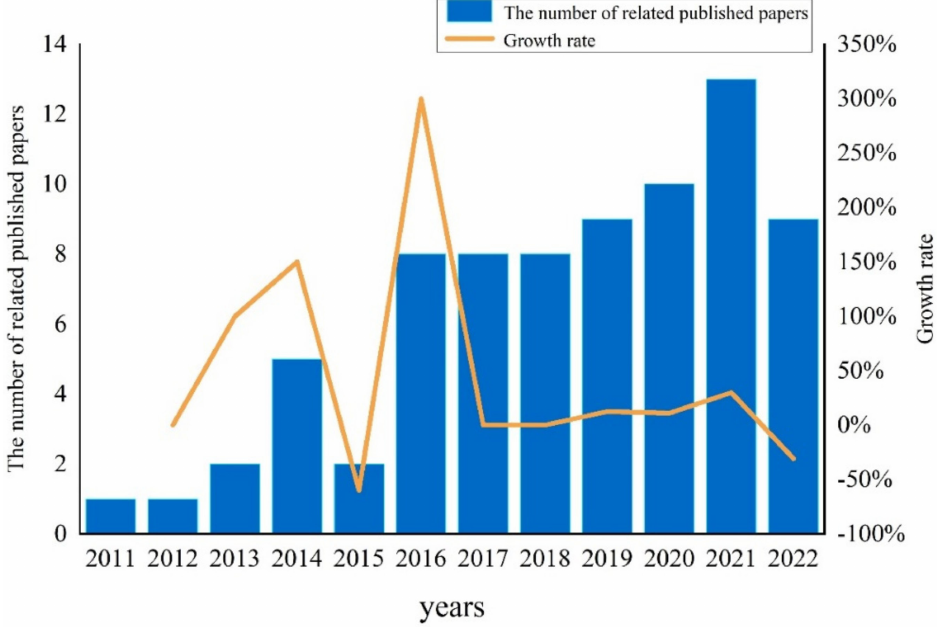
Figure 1. Statistics of related papers on the estimation of the SOH of EV